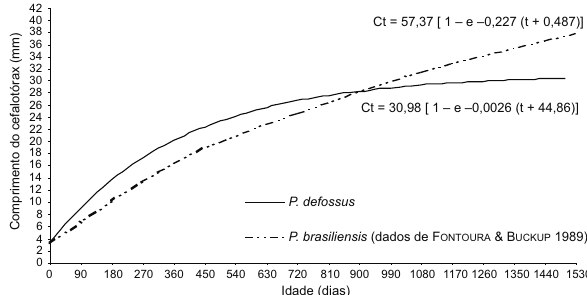
Figura 5. Comparação entre as curvas de crescimento em compri- mento da carapaça de P. defossus e P. brasiliensis , segundo dados de F ONTOURA & B UCKUP (1989), coletados em